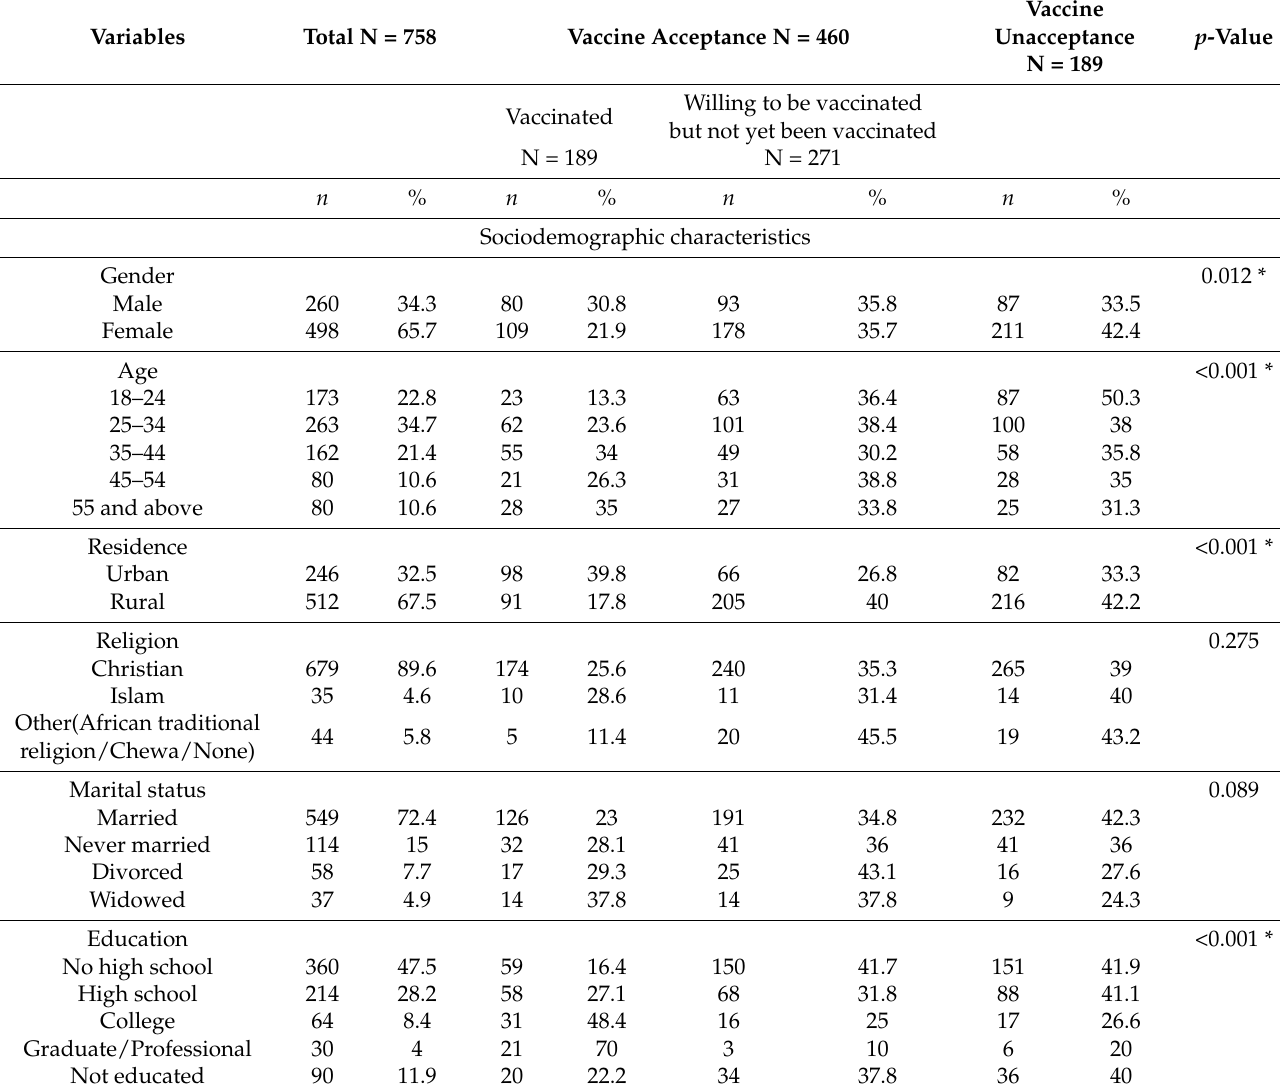
Table 1. Demographic characteristics and p -values of the